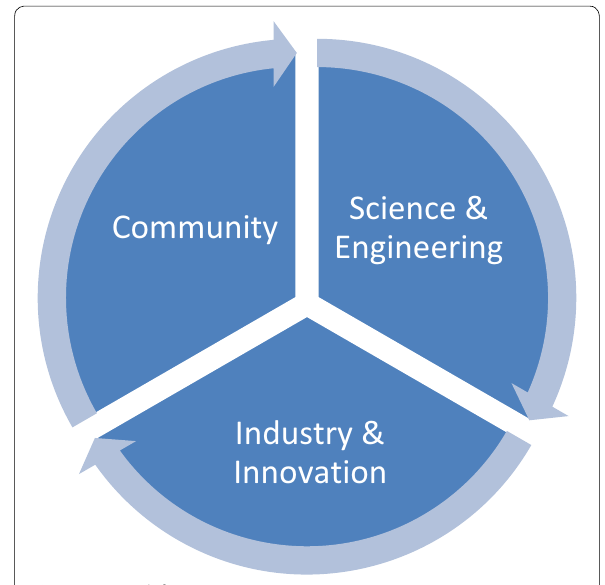
Fig. 1 Network focus